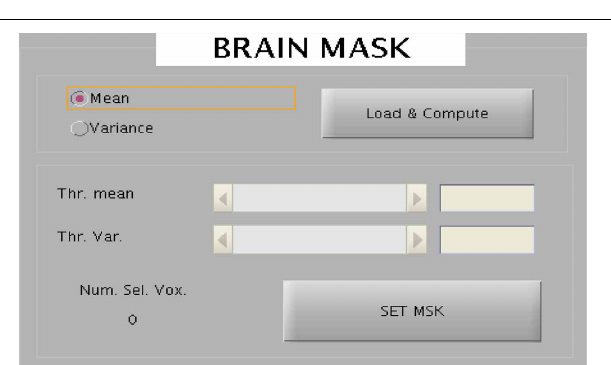
FIGURE 8 | The wizard shown above is used to create brain mask to reduce the dimensionality of the data. Two kinds of mask can be created: one represent all voxels in the brain and the other mask corresponds to the voxels belonging to the eyes.